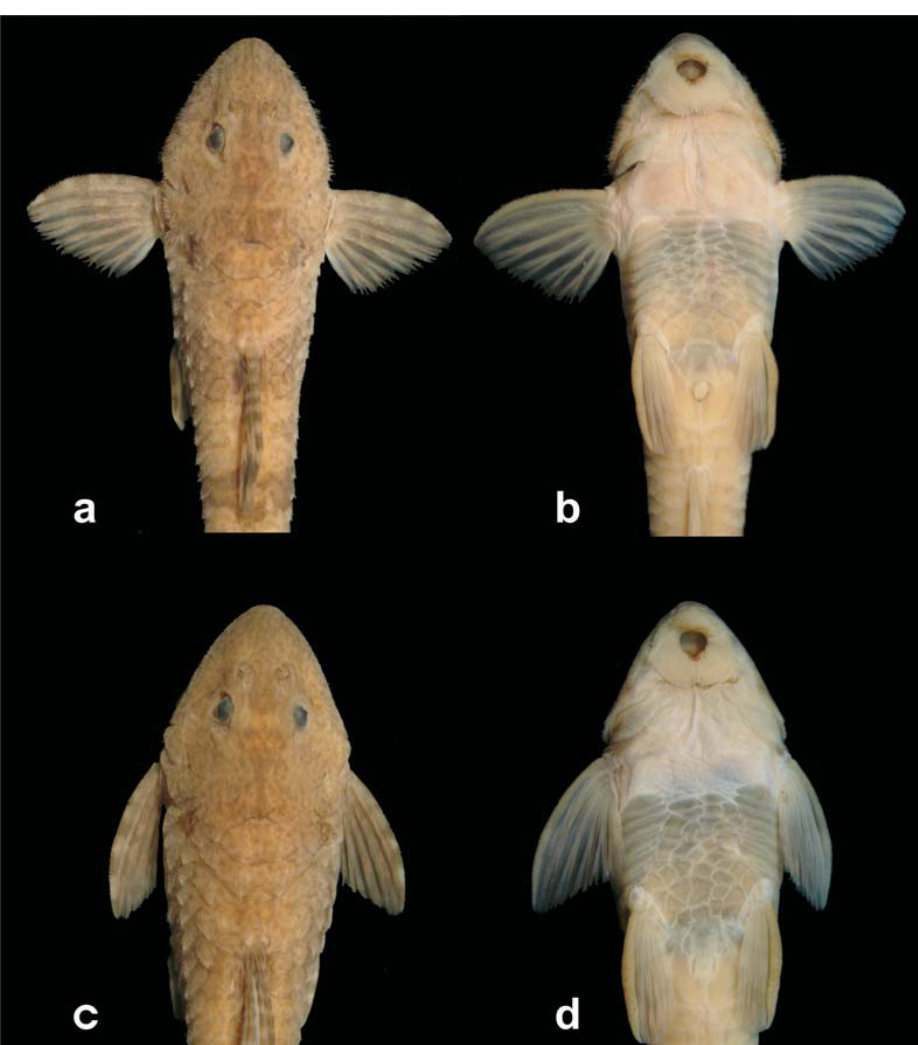
Fig. 5. Sexual dimorphism and plate distribution on abdomen and ventral region of pectoral girdle of Rineloricaria maacki . a- b : holotype, male, MNRJ 31158, 108.4 mm SL; c-d : paratype, female, MHNCI 11457, 113.00 mm